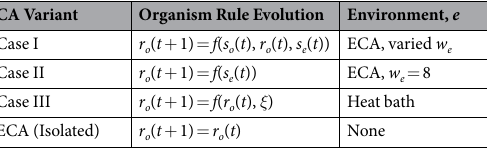
Table 2. Table of cellular automata variants, and the functional form of the rule evolution of o